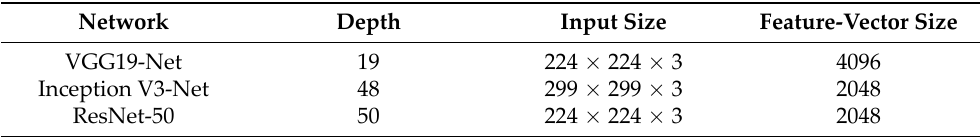
Table 1. Summary of pre‑trained network architecture.